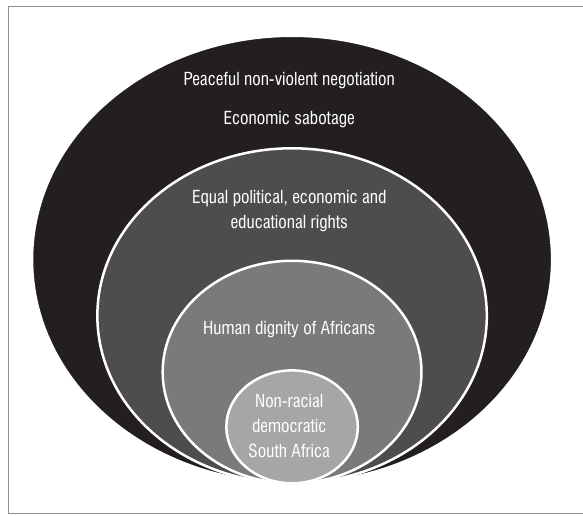
Figure 7: Main themes of the negotiation